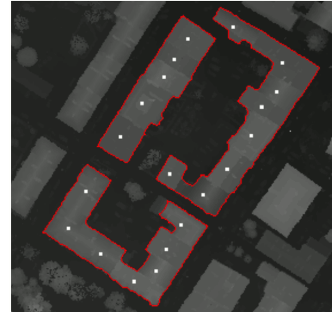
Figure 2b. Building region outlines detected in the high image.